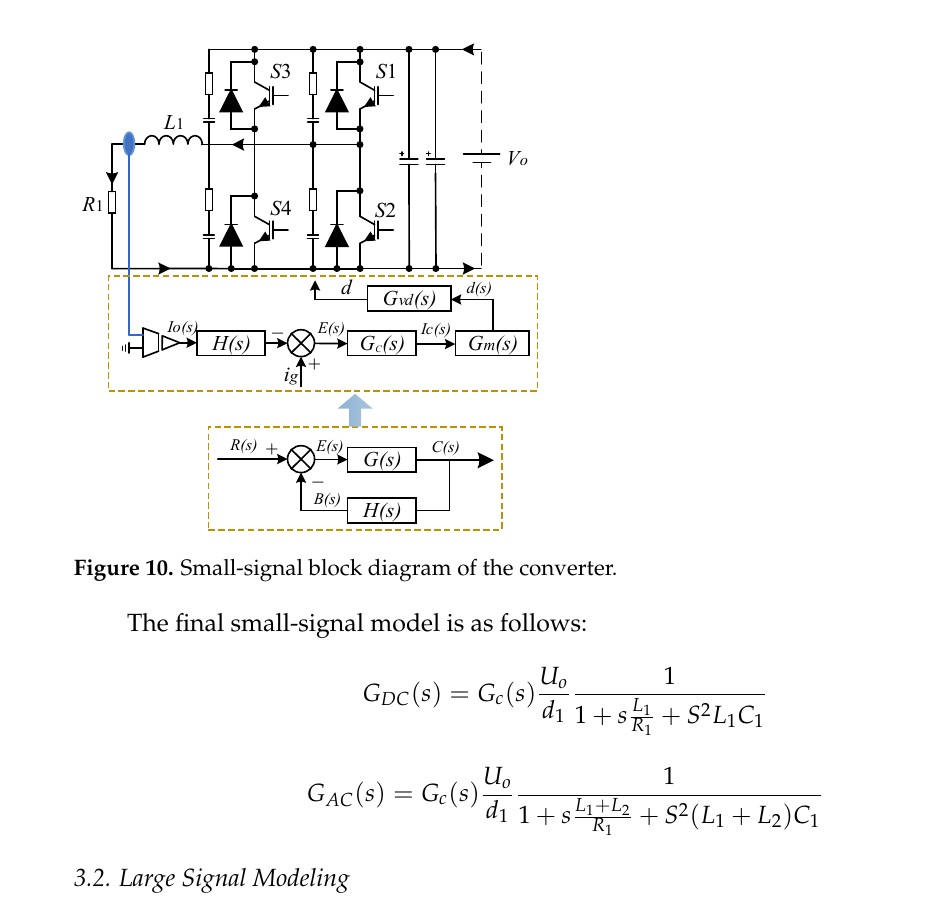
( b ) Figure 9. Small-signal model. ( a ) Small-signal model in DC mode ( b ) Small-signal model in AC mode. After obtaining the transfer function of the equivalent circuit, the equivalent small-